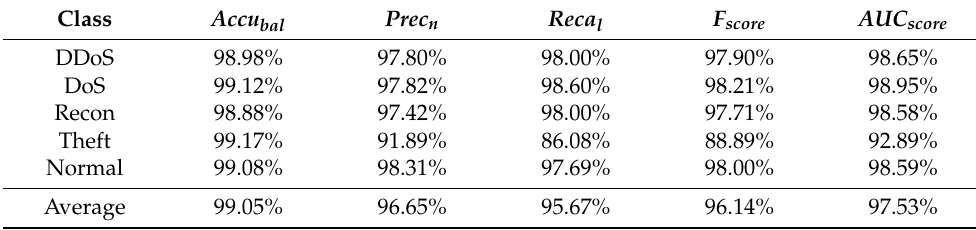
Figure 6. Loss curve of the H3SC-DLIDS approach on a binary dataset.